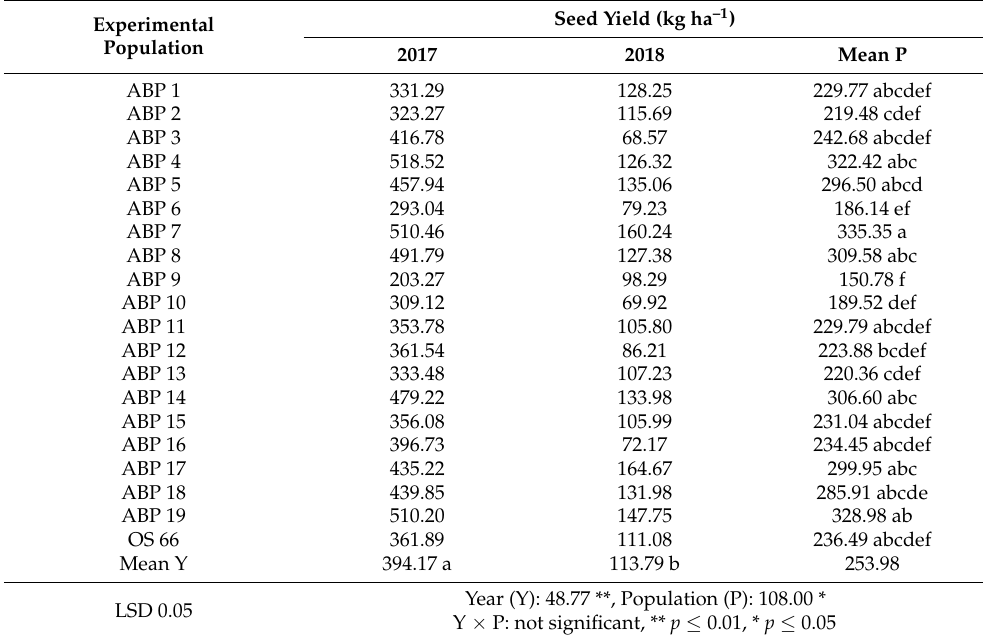
Table 4. Seed yield (kg ha − 1 ) of alfalfa experimental populations/cultivar during 2017 and 2018. Experimental